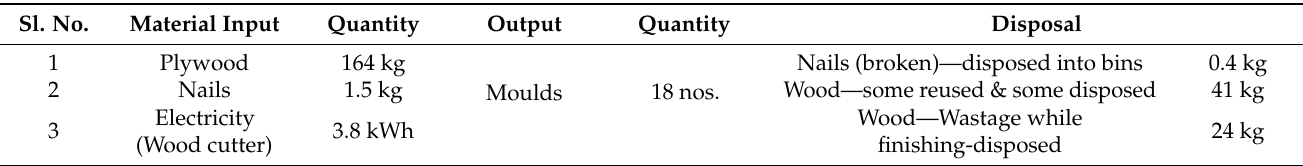
Table 4. Inventory details of Phase A—Mould